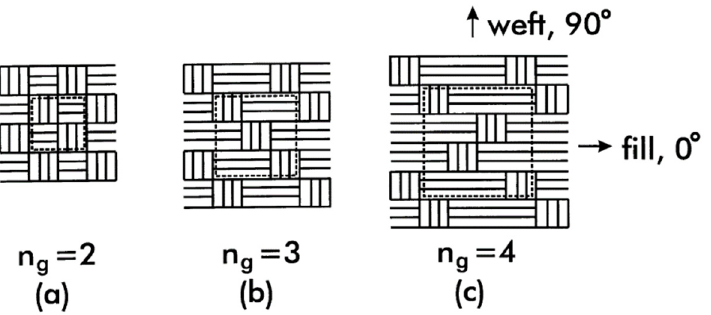
Figure 9. Different weaving patterns in hybrid woven fabrics: ( a ) plain, ( b ) twill, and ( c ) stain. Reprinted with permission from Reference [45].